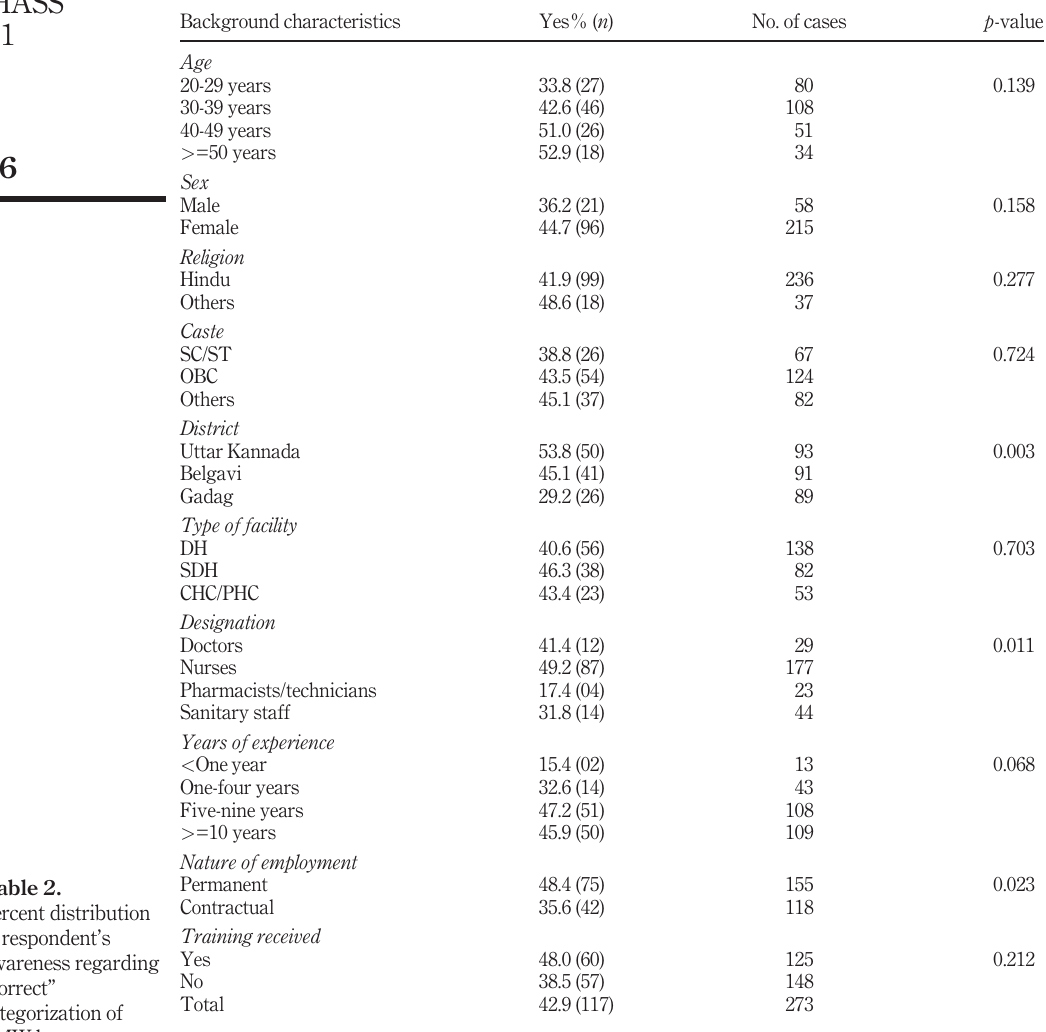
of respondent ’ s awareness regarding “ correct ” categorization of BMW by background